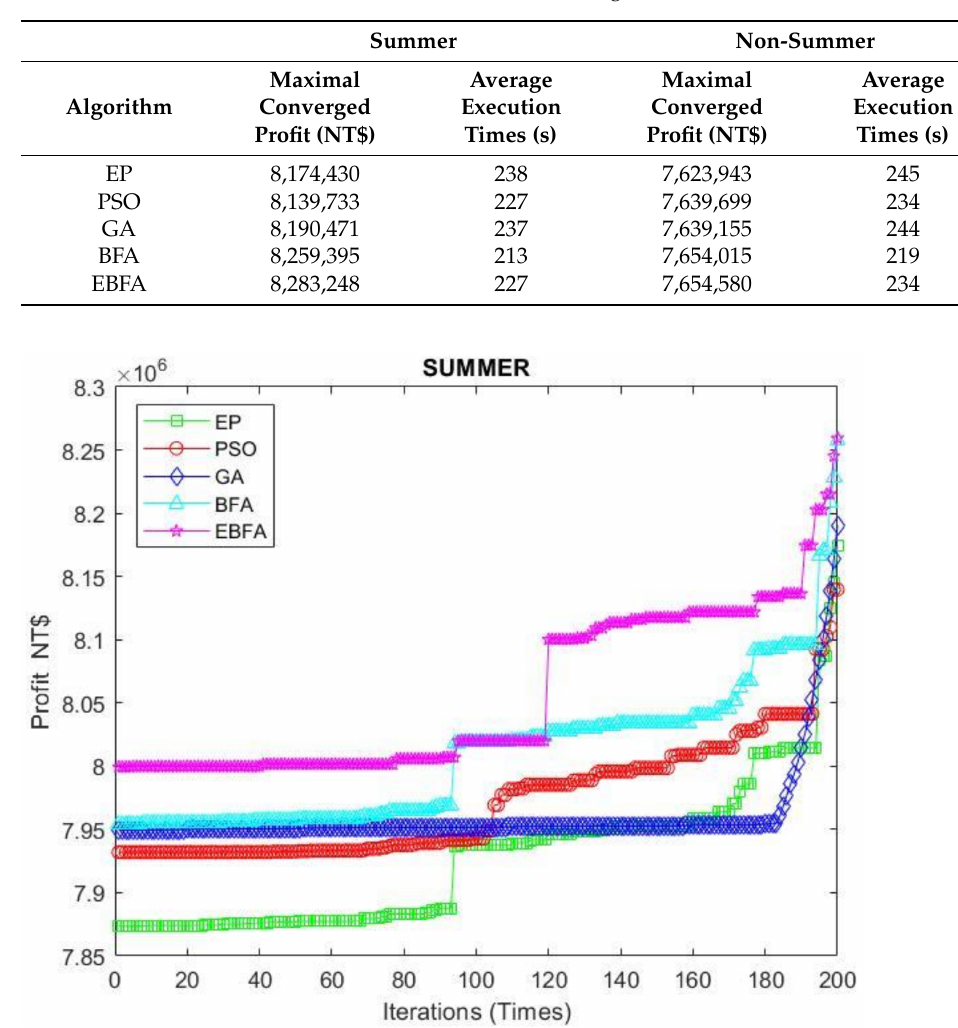
Figure 11. The summer daily profit of the VPP with various confidence levels. Table 3. Robustness test for EP, GA, PSO, BFA, and EBFA algorithms.